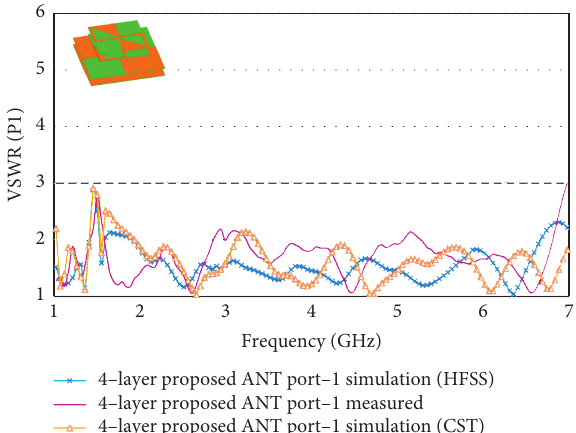
Figure 6: Measured and simulated VSWR (port-1) versus frequency of the proposed antenna.